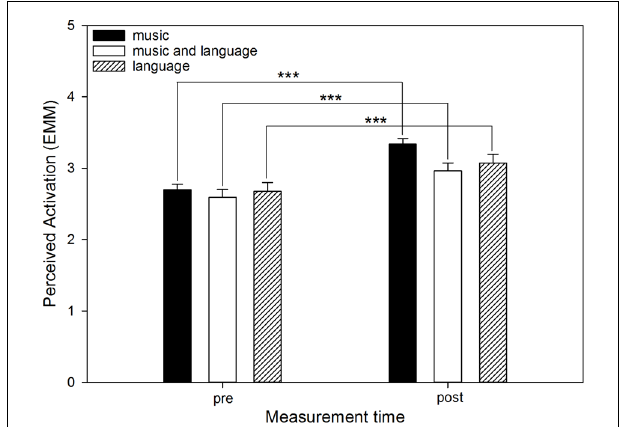
FIGURE 2 | Perceived activation by listening mode before and after using the app. The graph shows the EMM of perceived activation before (pre) and after (post) using the app, separated by the three modes (“music,” “music and language” and “language”). Error bars represent standard errors of EMM. There was a significant increase from before to after using the app when all sessions independently of the mode were taken into account. However, this increase only came about due to a significant increase in the mode “music.” ∗∗∗ p < 0.001.